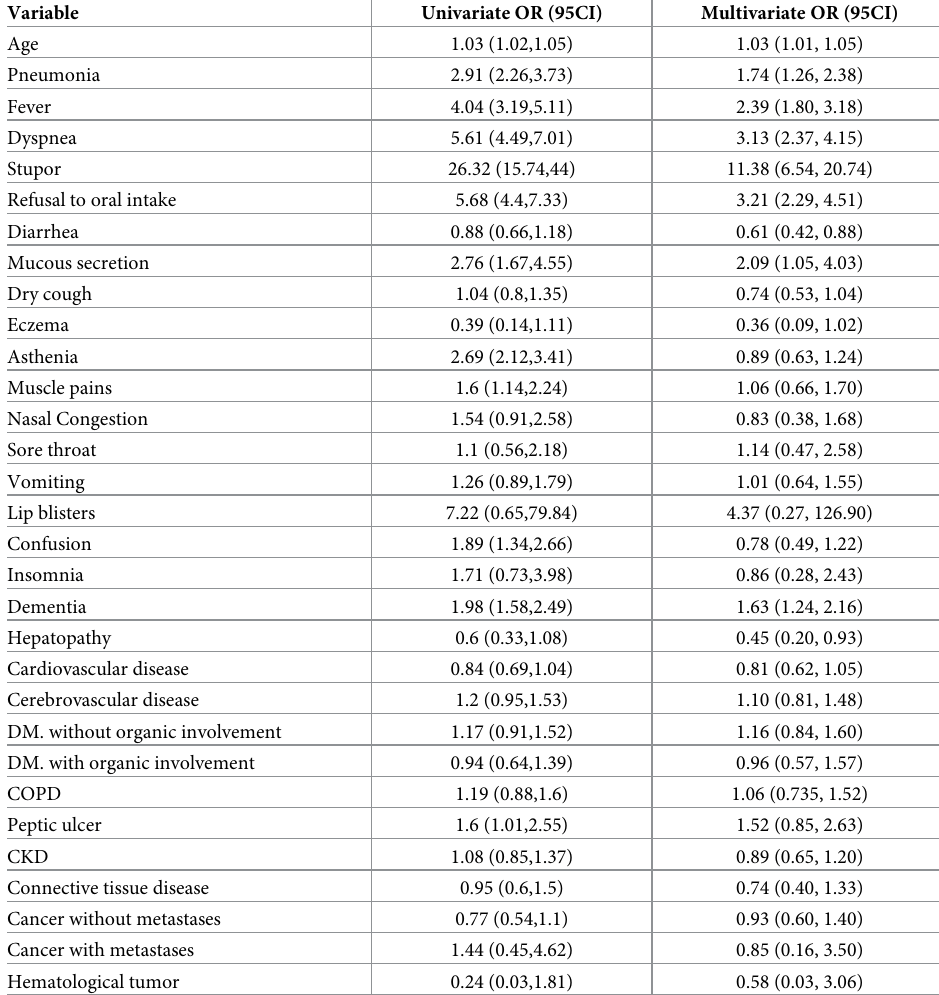
Table 2. Risk factors associated with exitus.